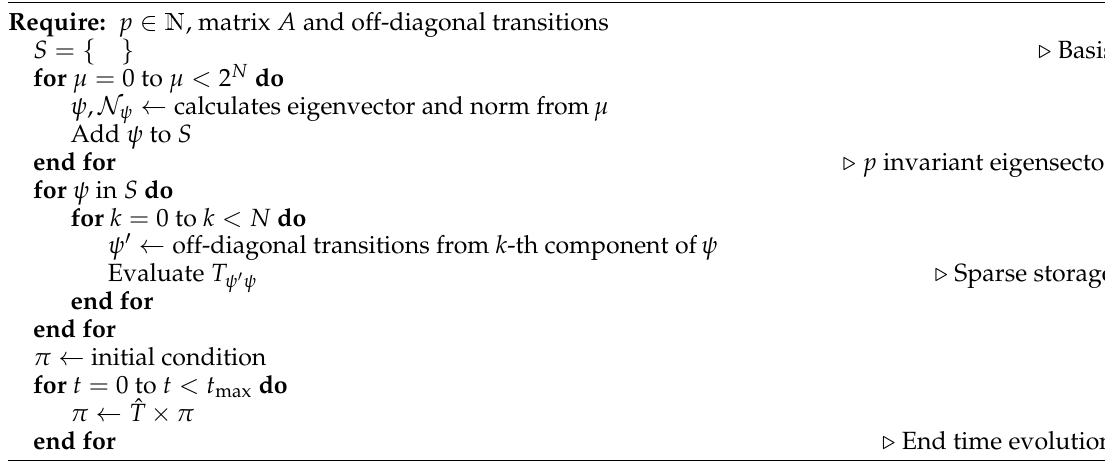
Algorithm A1. Time Evolution